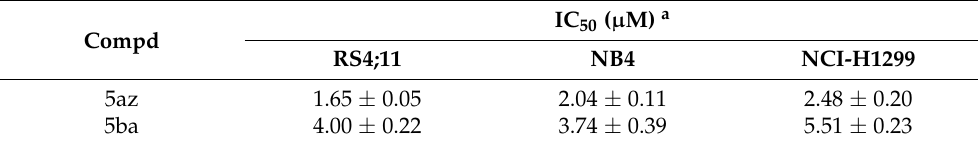
Table 5. Anti-tumor effects of compounds 5az-ba .